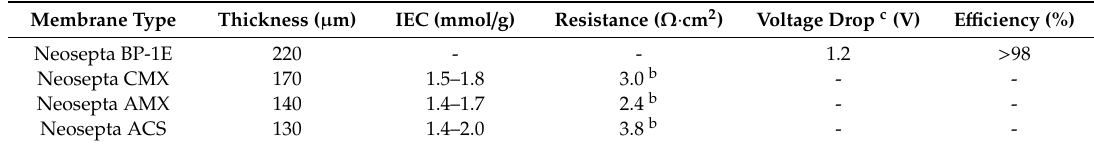
Table 2. The main properties of the membranes used for the experiments